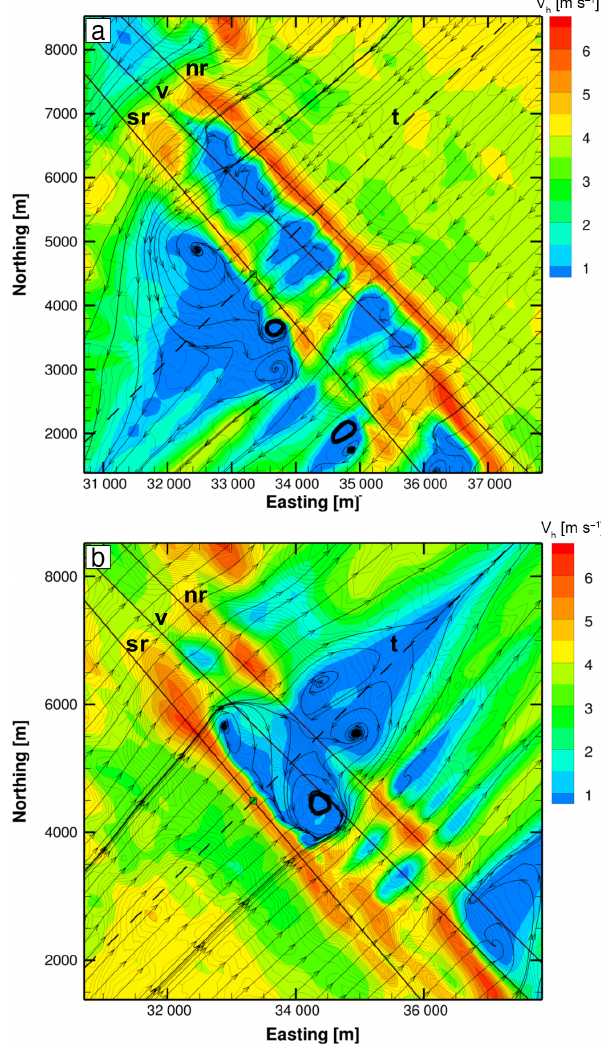
Figure 4. Simulated wind flow on a surface 80ma.g.l.: (a) north- east winds; (b) southwest winds. Positions expressed in datum ETRS89/PTM06 (m) (EUREF, 2016). Three thick diagonal lines denoted as sr, v and nr represent the south ridge, valley and north ridge lines. The dashed line denoted t represents the transect of in- terest.